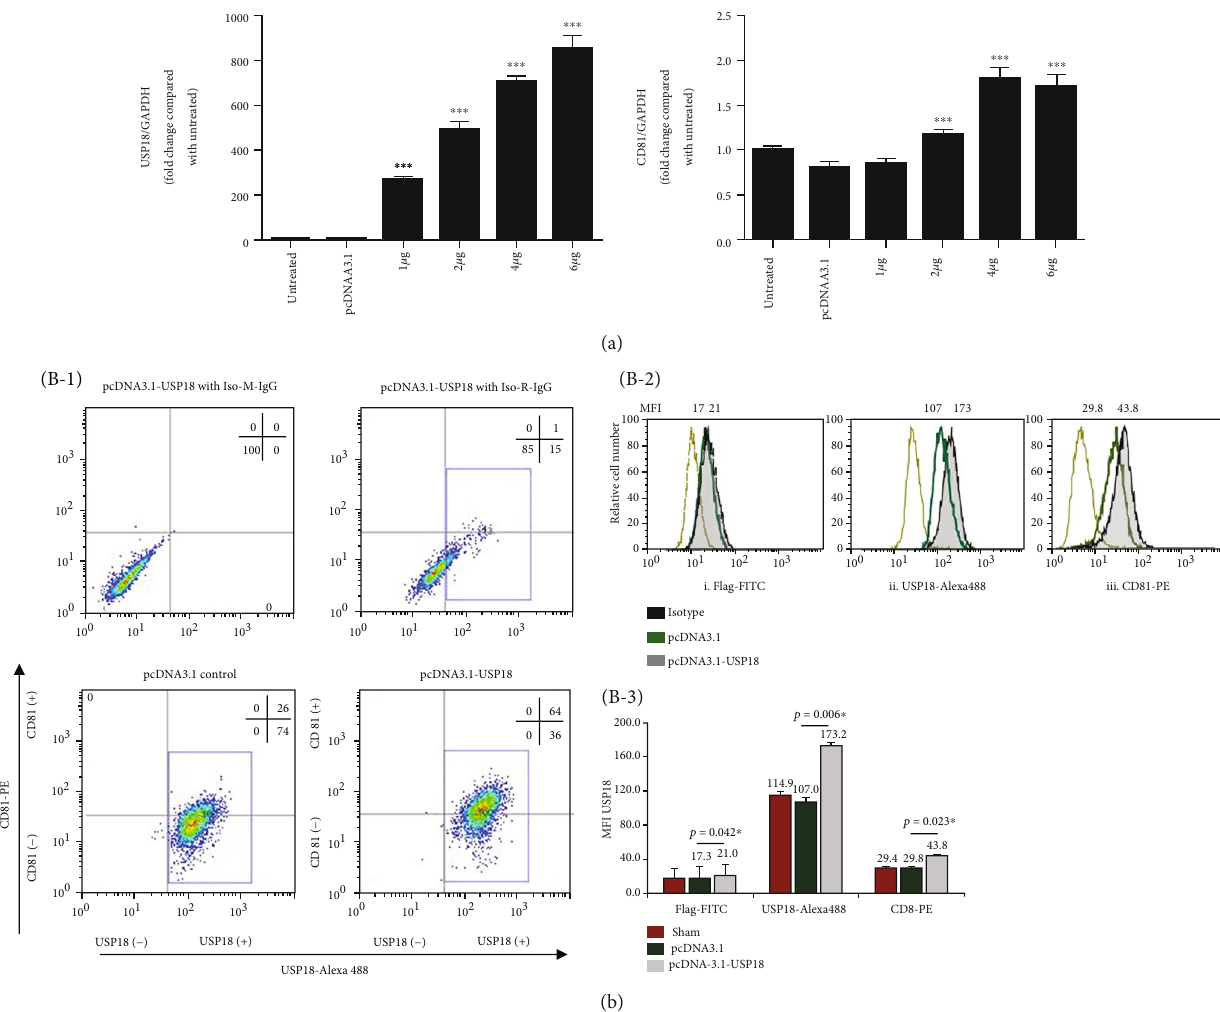
Figure 5: USP18 promotes HCV infectivity and CD81 expression in Huh7.5 cells. (a) Huh7.5 cells were seeded at 3 × 10 5 /ml, 2ml per well in 6-well plates in antibiotic-free medium for 24 hours before 1 μ g, 2 μ g, 4 μ g, and 6 μ g pcDNA3.1-USP18 or 4 μ g empty vector pcDNA3.1 was transfected into each well. 48 hours posttransfection, total RNA was extracted; USP18 and CD81 expression was quanti fi ed by qRT-PCR and normalized to GAPDH expression as previously described. (b) Huh7.5 cells were seeded at 3 × 10 5 /ml, 2ml per well in 6-well plates in antibiotic-free medium for 24 hours before 4 μ g pcDNA3.1-USP18 was transfected into each well. (B-1) Lower-left and lower right quadrants indicate that the cells were transfected with empty vector pcDNA3.1 or pcDNA3.1-USP18 at 72 hours, with the percentage of cells in respective quadrants. All dot blots show CD81 expression (vertical axis) according to USP18 expression (horizontal axis). Upper- left and right quadrants show the range of isotype control for PE- and Alexa 488-conjugated antibodies. (B-2) Huh7.5 cells with transfected empty vector pcDNA3.1 (open histogram, dark green line) or pcDNA3.1-USP18 DNA ( fi lled histogram) were stained with a mouse anti- fl ag primary/FITC-conjugated goat anti-mouse secondary antibody, rabbit anti-human USP18 primary/Alexa 488-conjugated goat anti-rabbit secondary antibody, and PE-conjugated anti-human CD81 monoclonal antibody. The cells transfected with pcDNA3.1- USP18 were also stained with mouse and rabbit IgG and isotype control antibodies (open histogram, brown line). (B-3) Comparison of USP18/CD81 expression in or on Huh7.5 cells with sham control, transfected pcDNA3.1 control, and pcDNA3.1-USP18 DNA. Bars indicate MFI of USP18 ð FITC andAlexa 488 Þ /CD81 ð PE Þ expression ± STDV . Untreated: untreated control; pcDNA3.1: transfected with 4 μ g empty vector pcDNA3.1; 1 μ g, 2 μ g, 4 μ g, and 6 μ g: transfected with 1 μ g, 2 μ g, 4 μ g, or 6 μ g pcDNA3.1-USP18; sham control: untreated Huh7.5 cells only. Results are presented as means ± SD ( n ≥ 3 ). ∗ p < 0 : 05 ; ∗∗ p < 0 : 01 ; ∗∗∗ p < 0 : 001